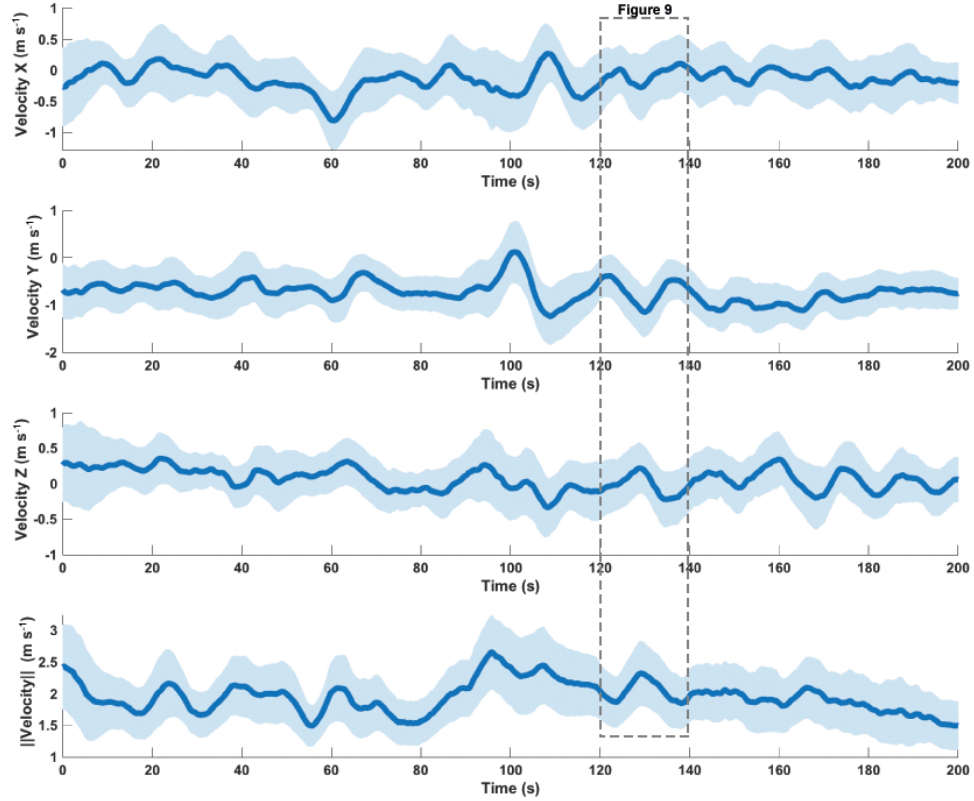
Figure 8. Mean values and 95% CI of the three velocity components and velocity magnitude of 40 deployments ( n = 40) over the first 200s of the flow path passage. The data are averaged over a 5s time